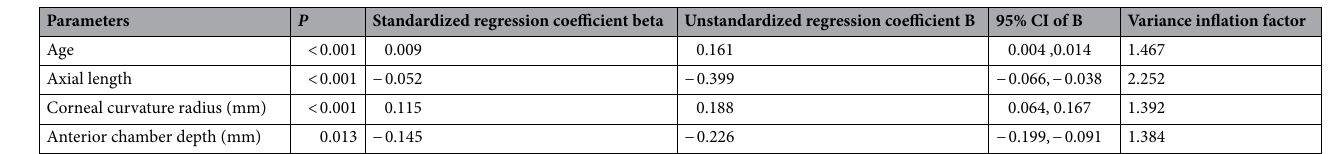
Table 3. Multivariate linear regression analysis of associations between lens thickness and ocular and systemic parameters in the Qinghai Children Eye Study.